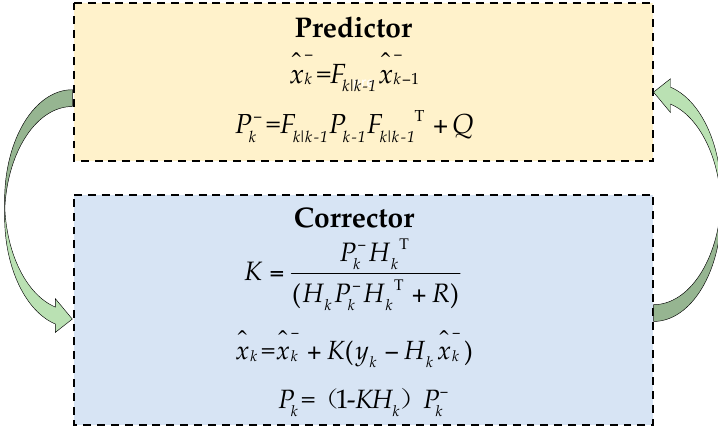
Figure 5. Predictor-corrector algorithm of Kalman filter.